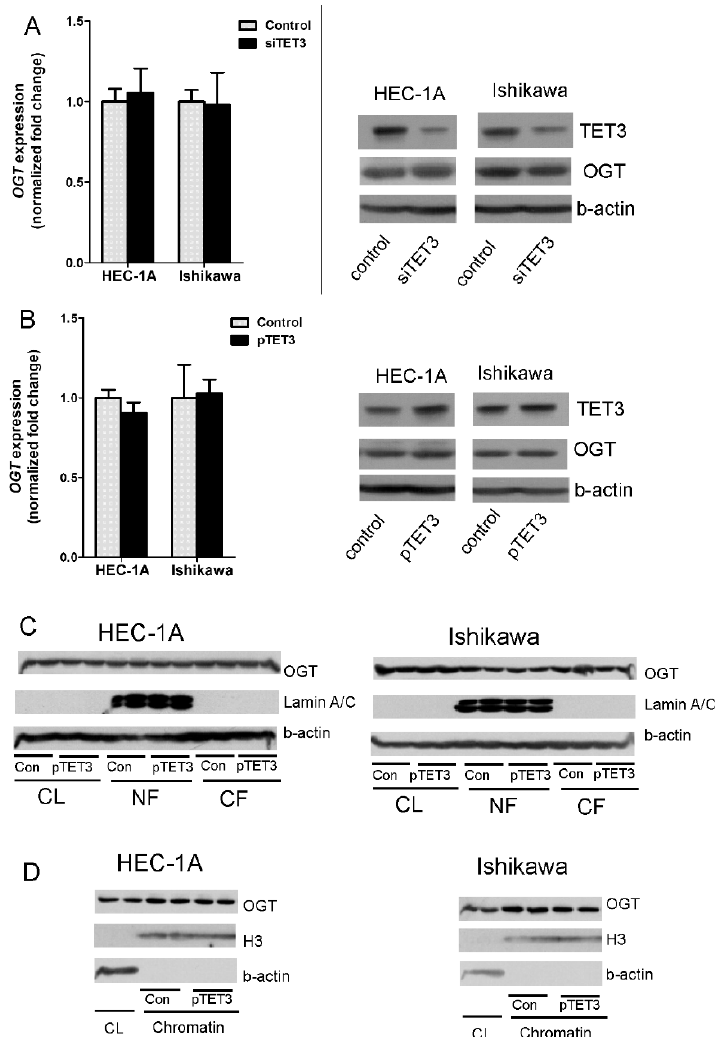
Figure 2. OGT expression and localization in cells with TET3 deregulation. OGT expression was analyzed at mRNA and protein levels in HEC-1A and Ishikawa cells with TET3 reduced ( A ) or increased ( B ) expression using the real-time PCR method or Western blot method. ( C , D ) are the results of OGT identification by Western blot method in cellular fractions in control cells and cells with TET3 overexpression. CL—whole cell lysate; NF—nuclear fraction; CF—cytoplasmic